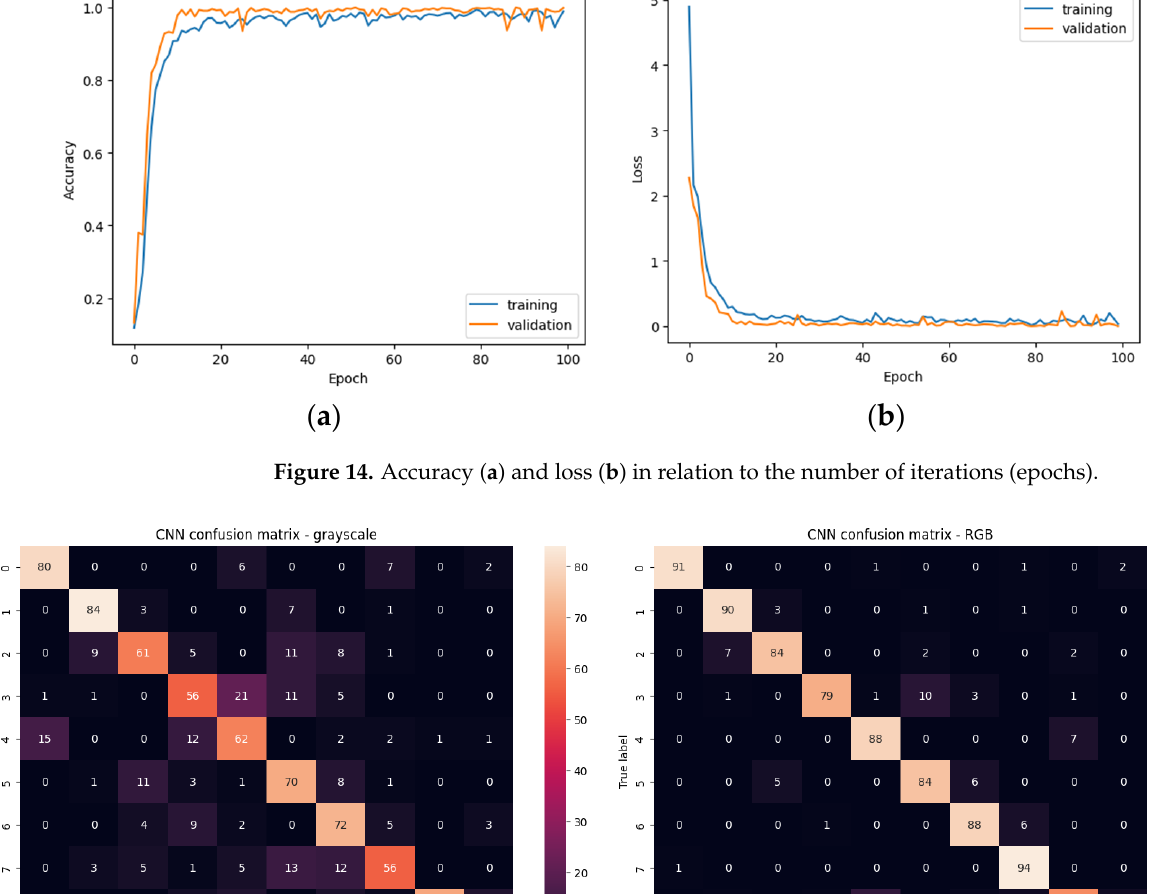
Figure 13. Accuracy ( a ) and loss ( b ) in relation to the number of epochs.